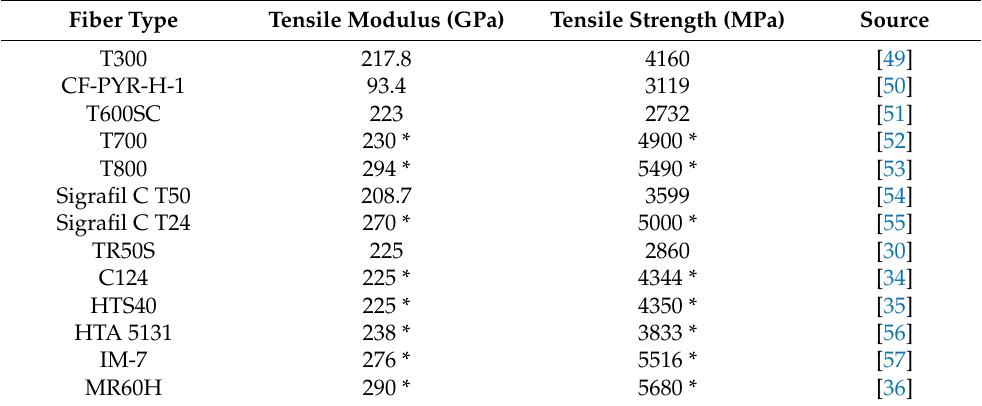
Table 1. Single fiber tensile properties for carbon fibers used in recycled carbon fiber composite